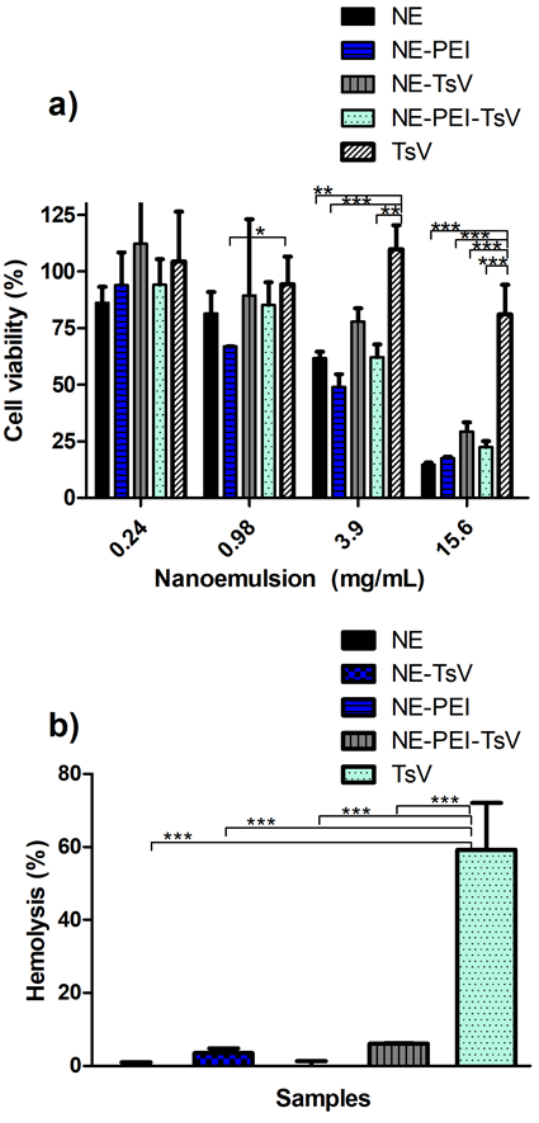
Figure 4. ( a ) Cell viability test on RAW 264.7 cells against different formulation and TsV alone. ( b ) Hemolysis test on human red blood cells against different formulation and TsV alone. The comparisons were performed using the one-way ANOVA followed by the Tukey’s post-test. A p < 0.05 was represented as *, p < 0.01 as ** and p < 0.001 as ***. Note: TsV = 0.018 mg/mL for loaded nanoemulsions and TsV alone.